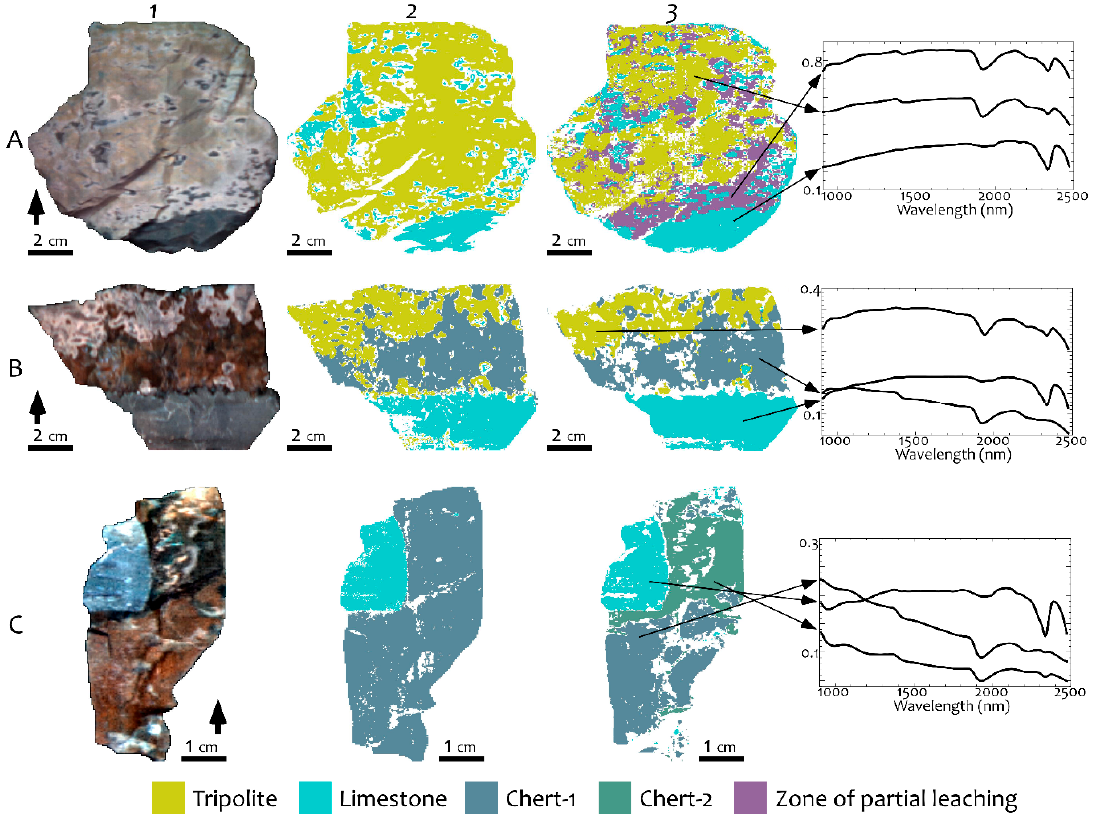
Figure 16. Laboratory-based image analysis results of samples collected during the field campaign. Figure ( A ) Limestone–tripolite contact right above the persistent limestone layer within tripolite; ( B ) limestone–chert contact within the transition zone showing stylolite along the contact and early stages of tripolitization in the upper portion; and ( C ) limestone–chert contact from interbedded Lower Reeds Spring.